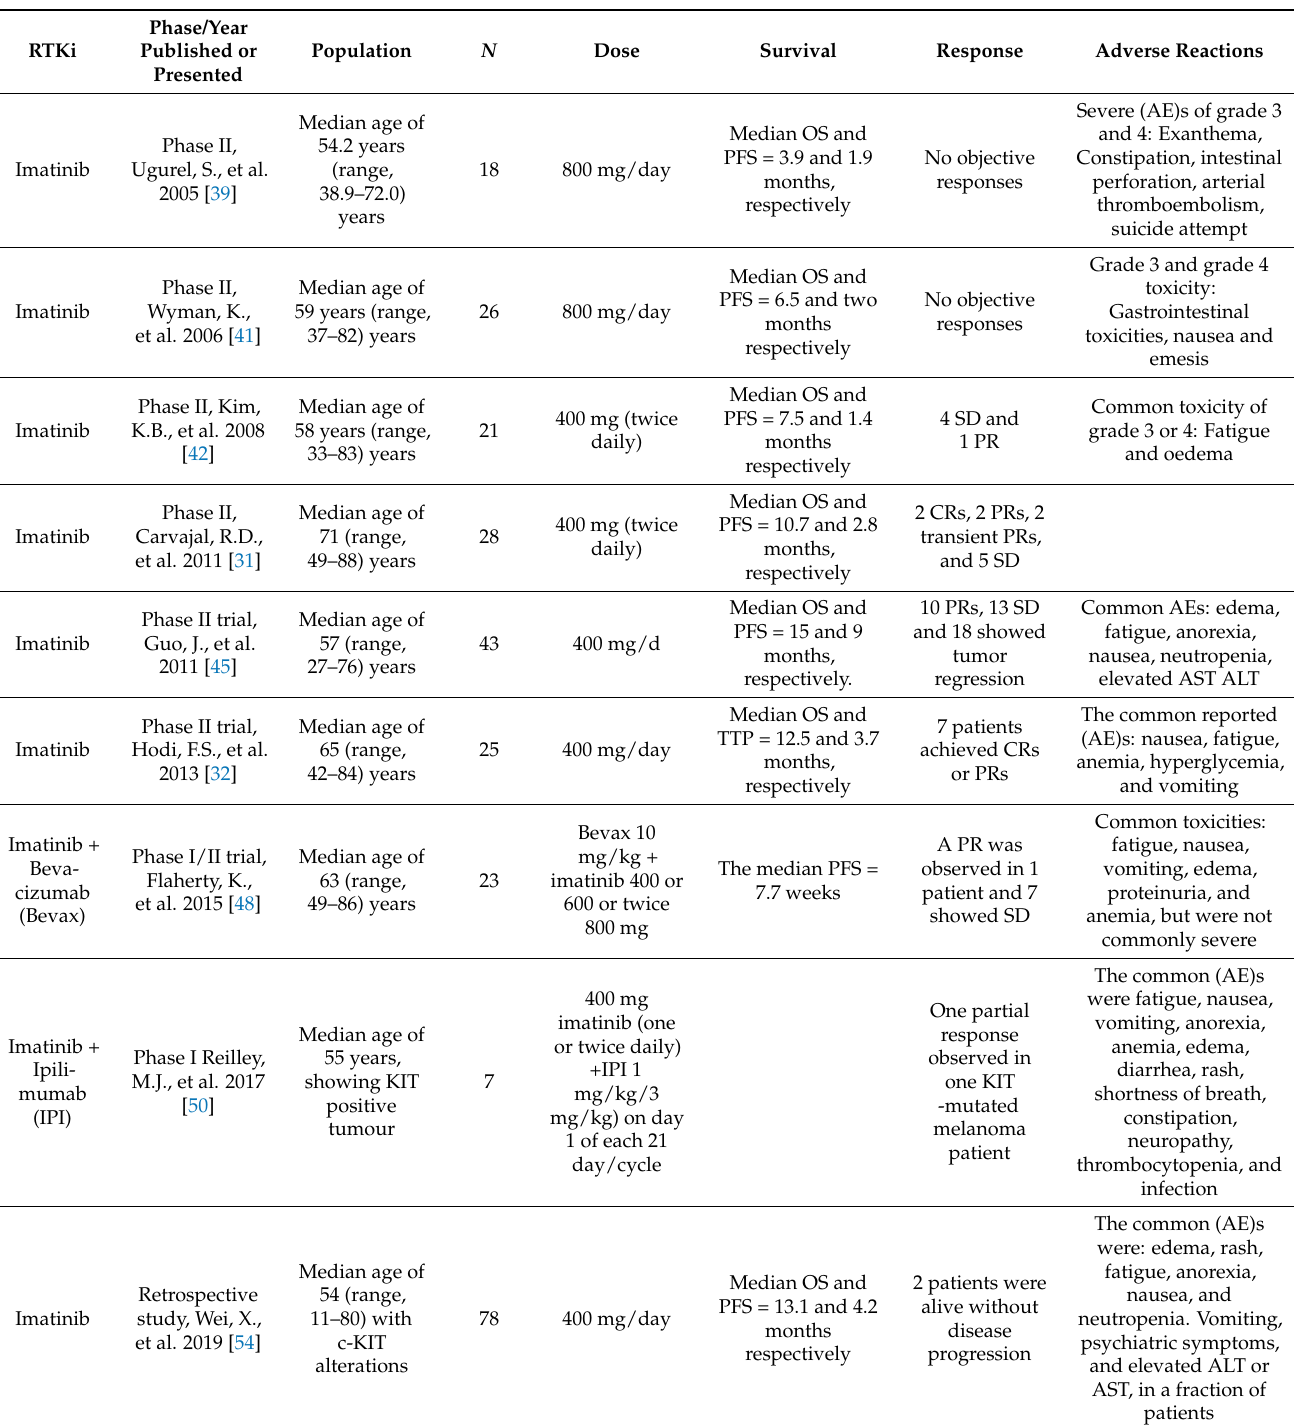
Table 2. Effect of imatinib alone or in combination in melanoma clinical